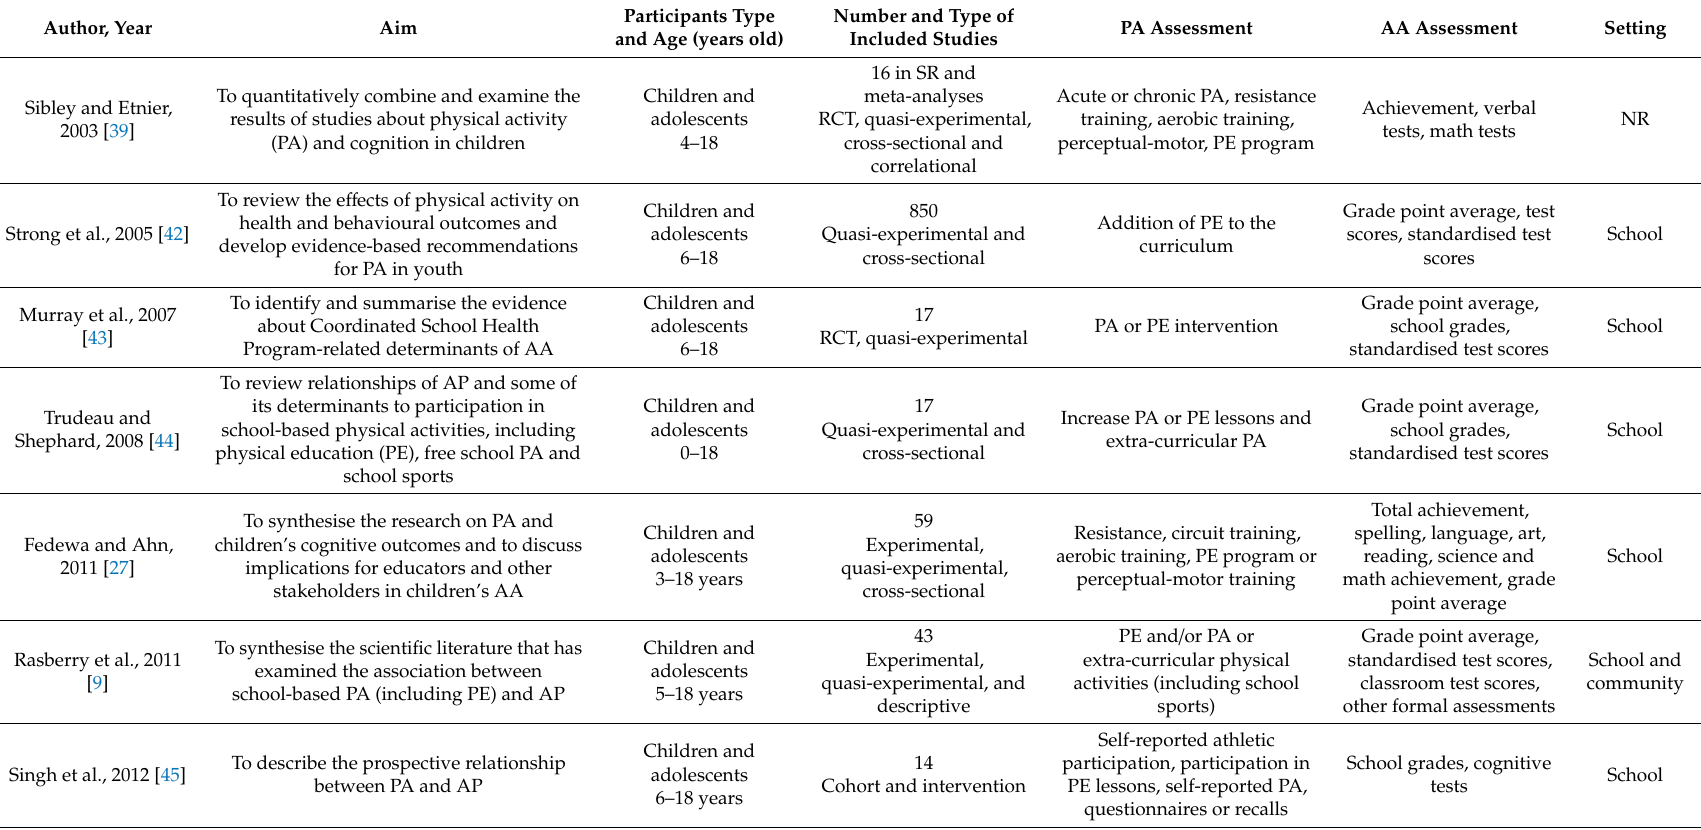
Table 1. Summary table of included